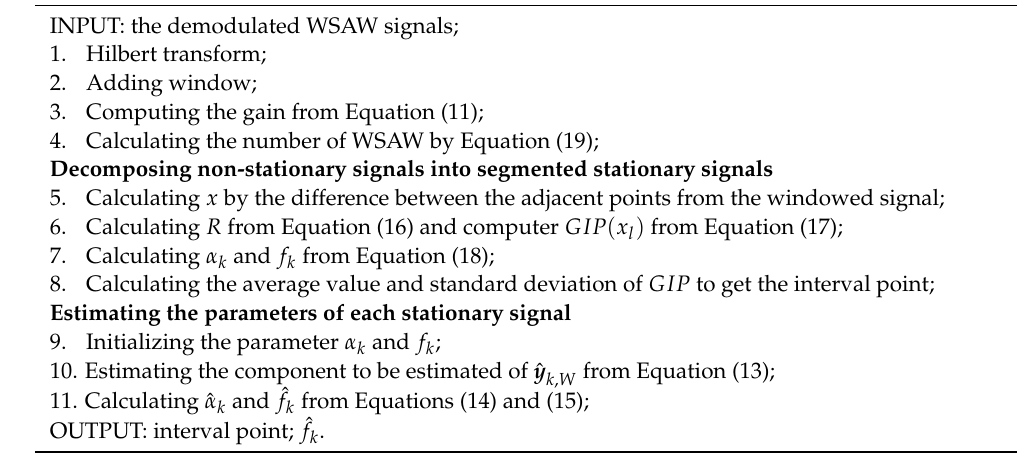
Algorithm 1: Improved RELAX to estimate the WSAW parameter.